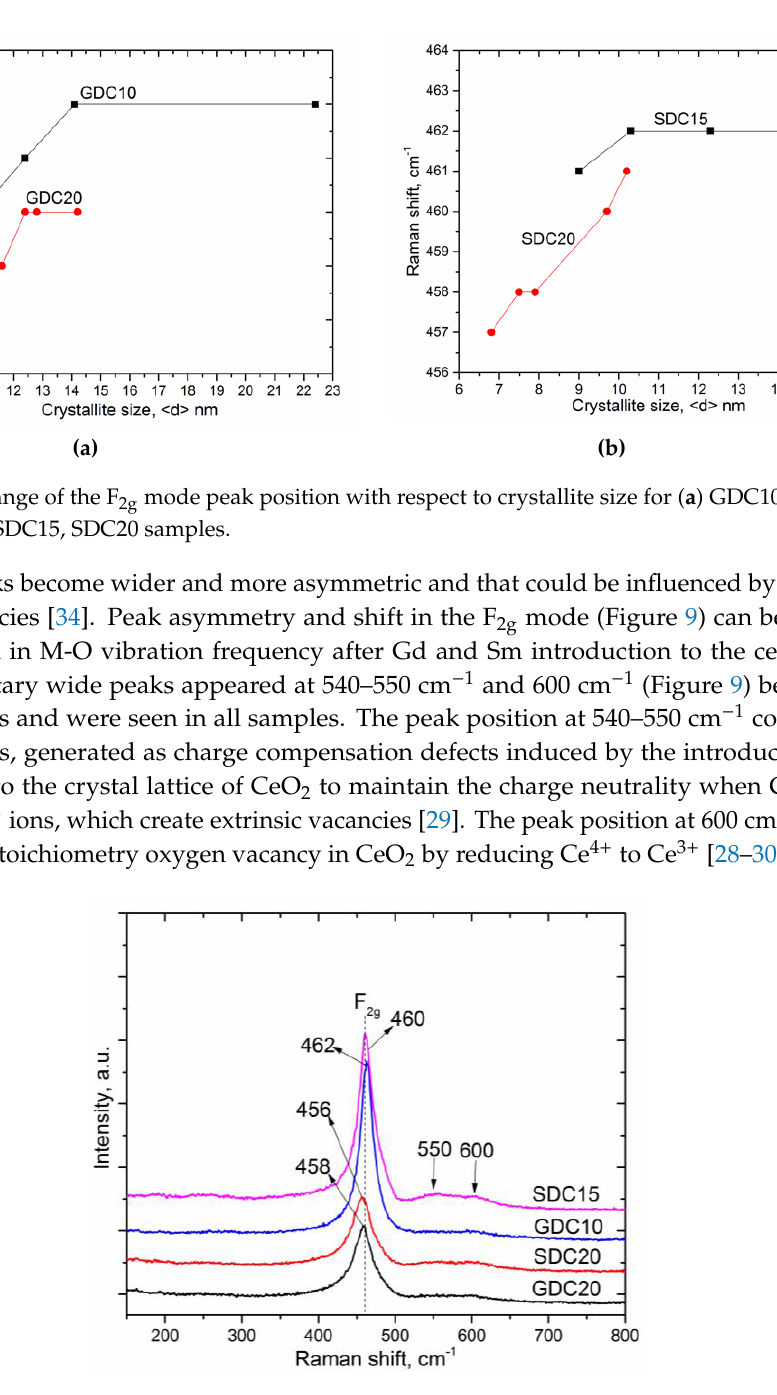
Table 3. Change of the F2g mode peak position and FWHM with respect to dopant concentration and lattice constant GDC10, GDC20, SDC15, and SDC20 thin films.